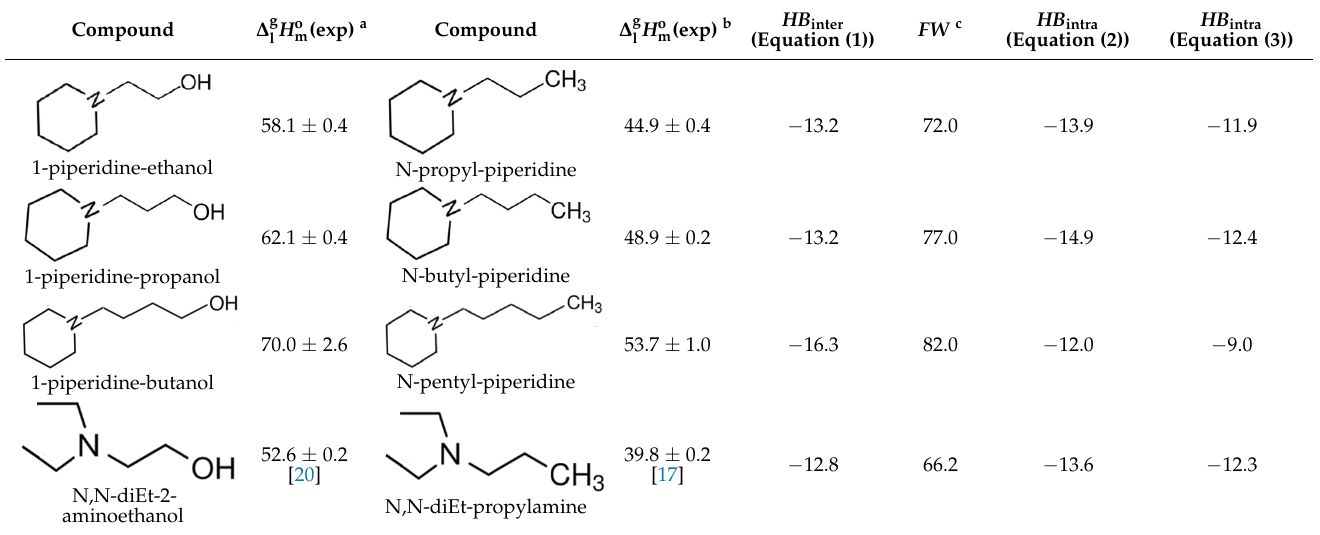
Table 2. Experimental enthalpies of vaporisation of hydroxy-alkyl-piperidines and N-alkyl-piperi- dines and the strength of inter- and intra-HBs calculated from these values (at 298 K, in kJ mol −1 ).